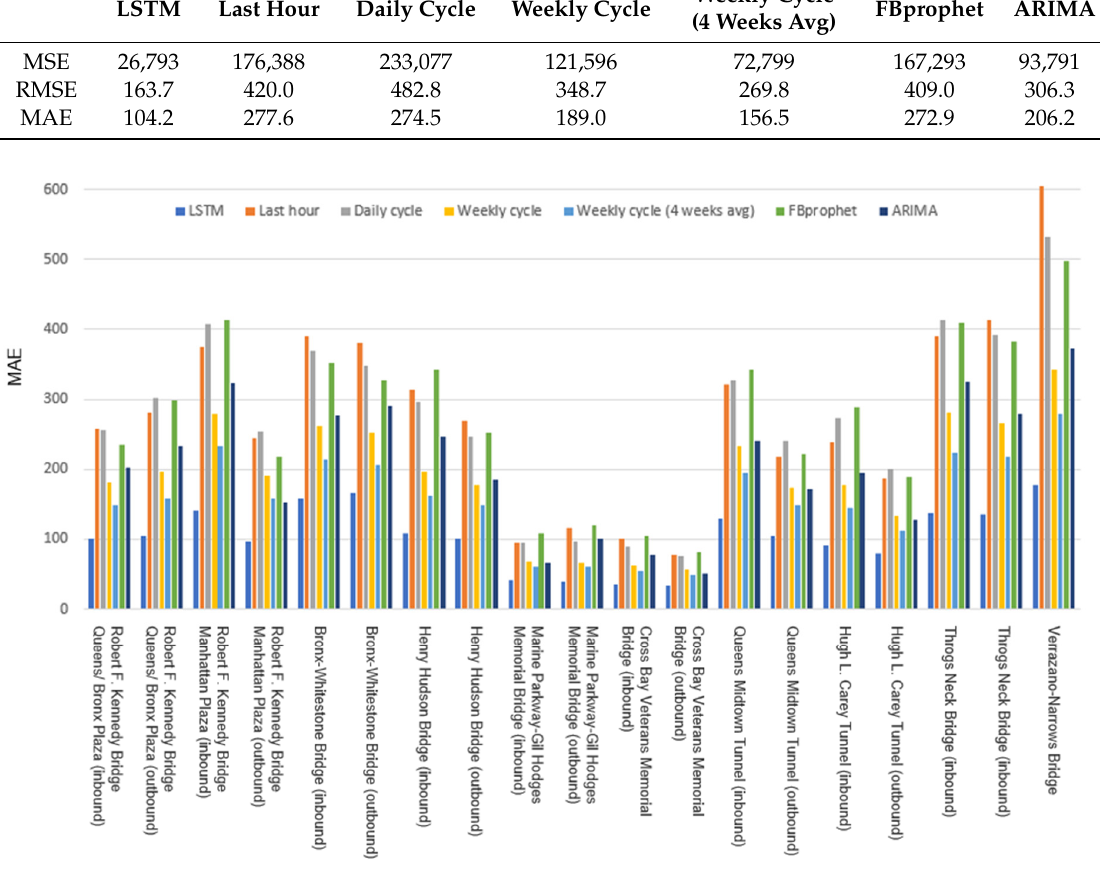
Table 1. Overall comparison results of the LSTM model and the baseline approaches in terms of MSE, RMSE, and MAE.